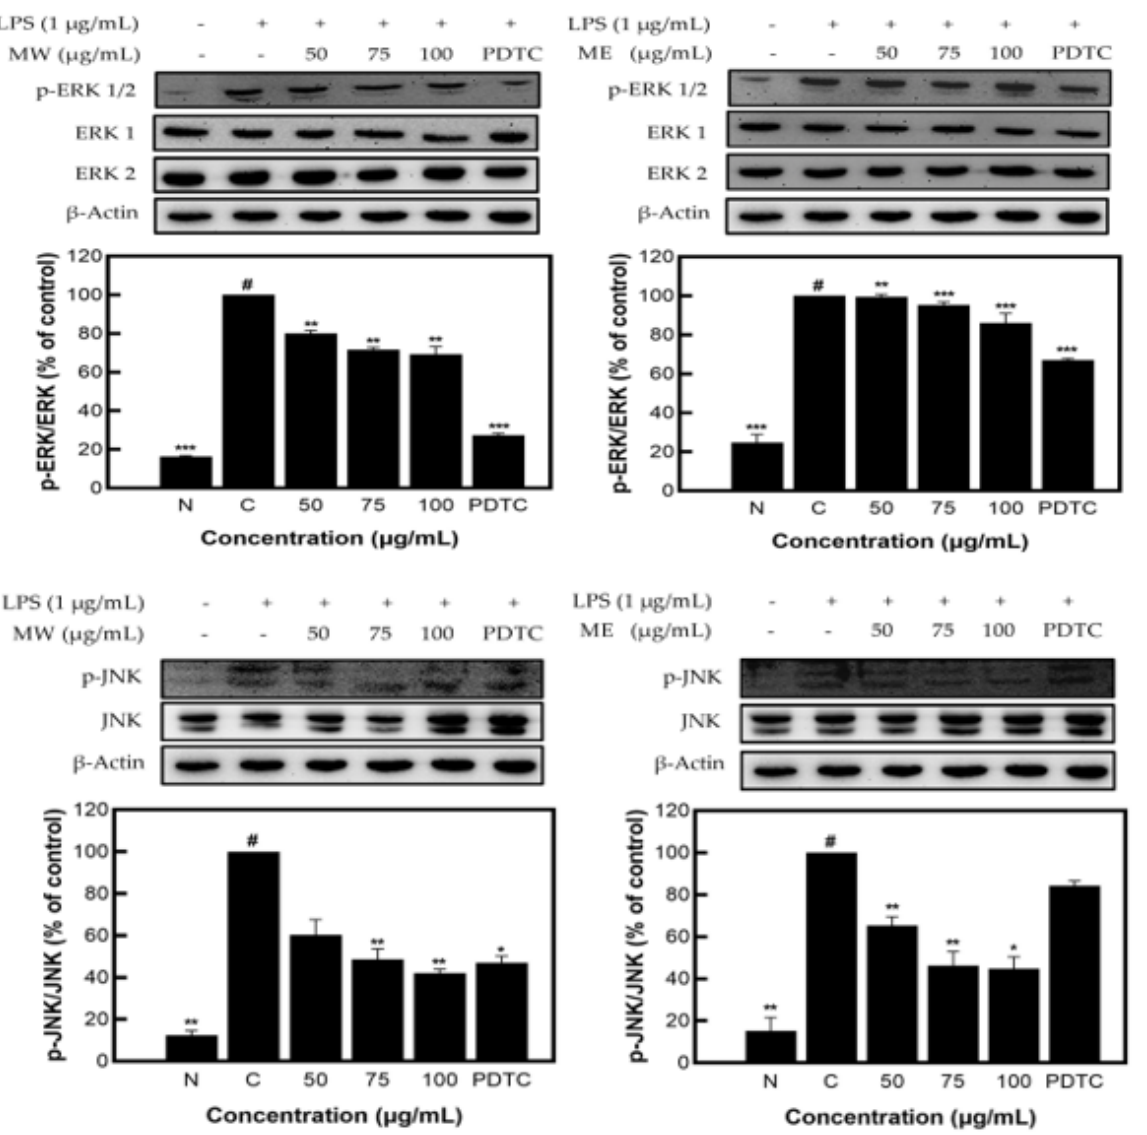
Figure 4. JNK, p-JNK and ERK1/2, p-ERK1/2 protein expression rate of M. pruriens extract on macrophage cell (RAW 264.7). MW: M. pruriens extracted with hot water; ME: M. pruriens extracted with 70% ethanol; PDTC: ammonium pyrrolidine dithiocarbonate. N: normal, not treated with LPS; C: control, LPS-treated. Results are means ± SD of triplicate data (significantly different according to a Tukey test and significant as compared to the control. # p < 0.05 vs. non-treated N, * p < 0.05, ** p < 0.01, *** p < 0.001).